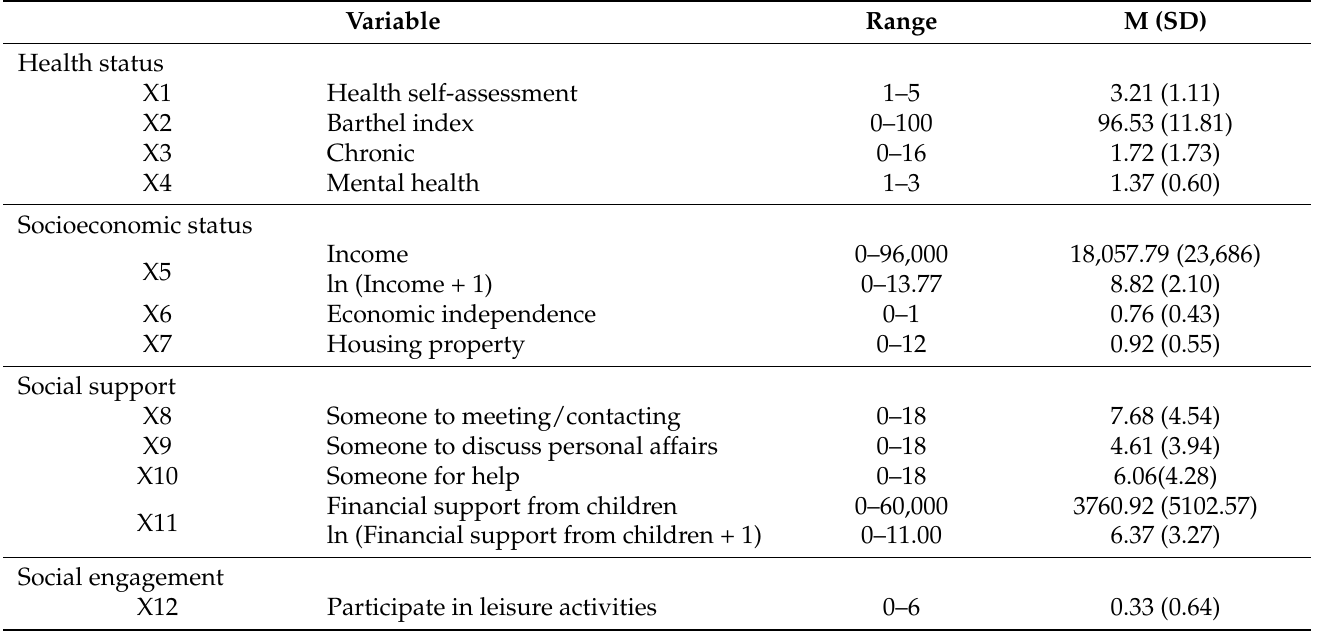
Table 2. Characteristics of items for the identification of vulnerable older adults (N = 11,511). Variable Range M